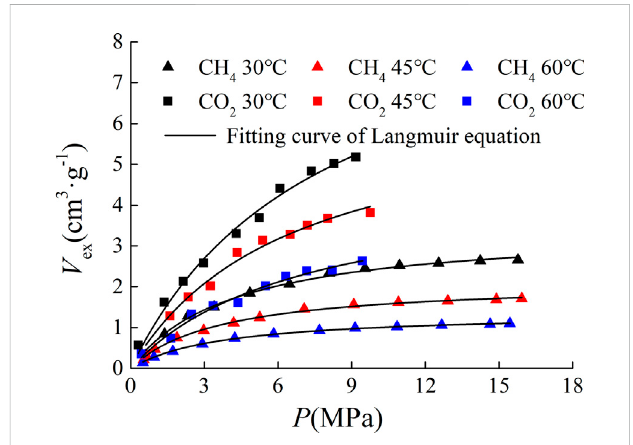
The sorption isotherm of shale of Yanchang